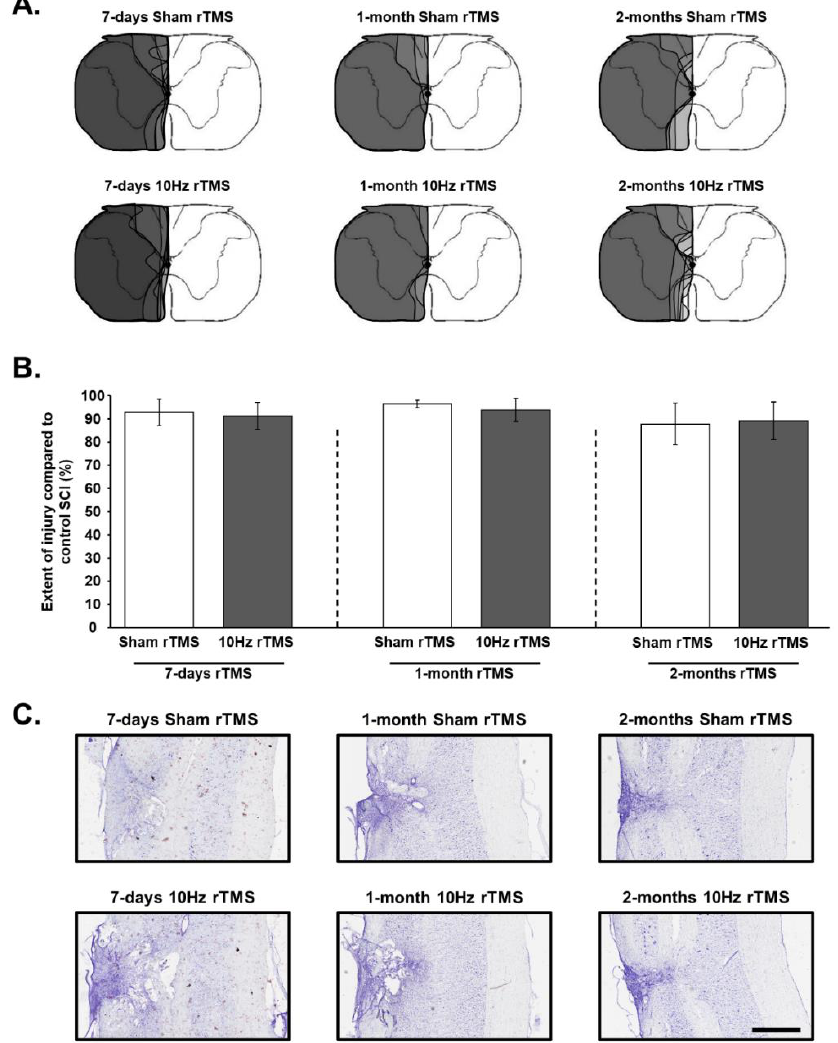
Figure 2. Extent of injury following a C2 spinal cord hemisection: ( A ) representative schematic diagrams of the extent of injury in each animal at 15 days postinjury (P.I.) for 7-day Sham and 10 Hz rTMS groups, 36 days P.I. for 1-month Sham and 10 Hz rTMS groups, and 64 days P.I. for 2-month Sham and 10 Hz rTMS groups; ( B ) extent of injury quantification in percentage compared with control spinal cord injury (SCI) 100%. The quantification has been made only in the ventral part where the phrenic motoneurons are located. There is no difference between the different groups (One Way ANOVA, p = 0.235); ( C ) representative image for each group stained in cresyl violet. Scale Bar: 1